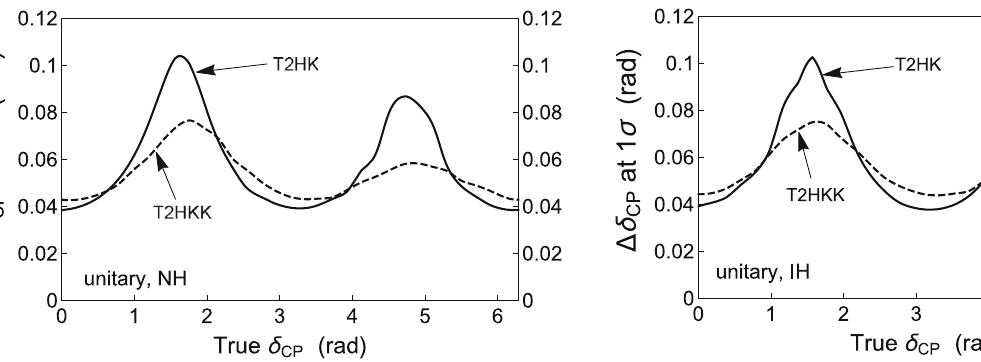
Fig. 8 The resolution of the δ CP measurement when non-unitarity is absent, quantified as the difference between δ CP that gives χ 2 = 1 and the true δ CP Eq. (36). The results are presented as functions of the true δ CP . The left and right plots correspond to the cases when the true